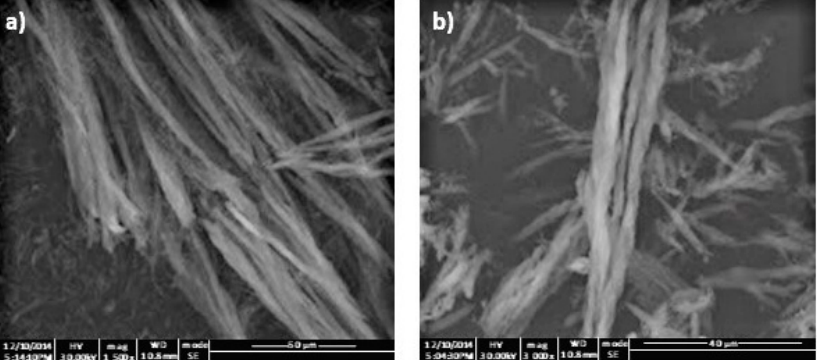
Figure 1. Scanning electron micrographs of the synthesized molecularly imprinted microrods (MIMs) ( a ) and non-molecularly imprinted microrods (NIMs) ( b ).